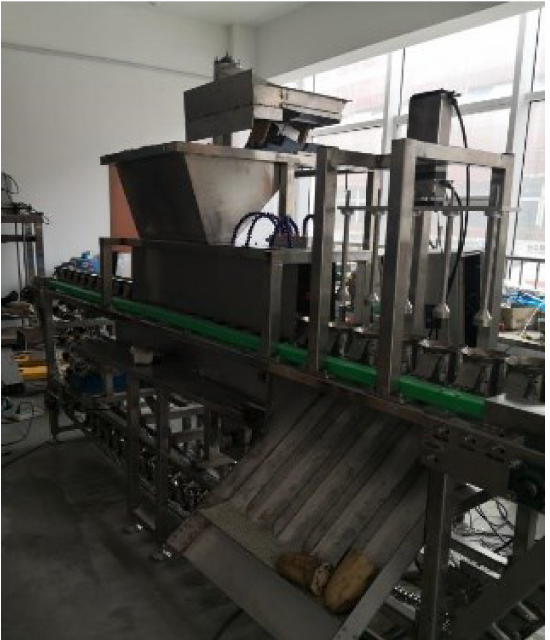
Figure 5. Prototype of automatic rice-filling device for lotus root with glutinous